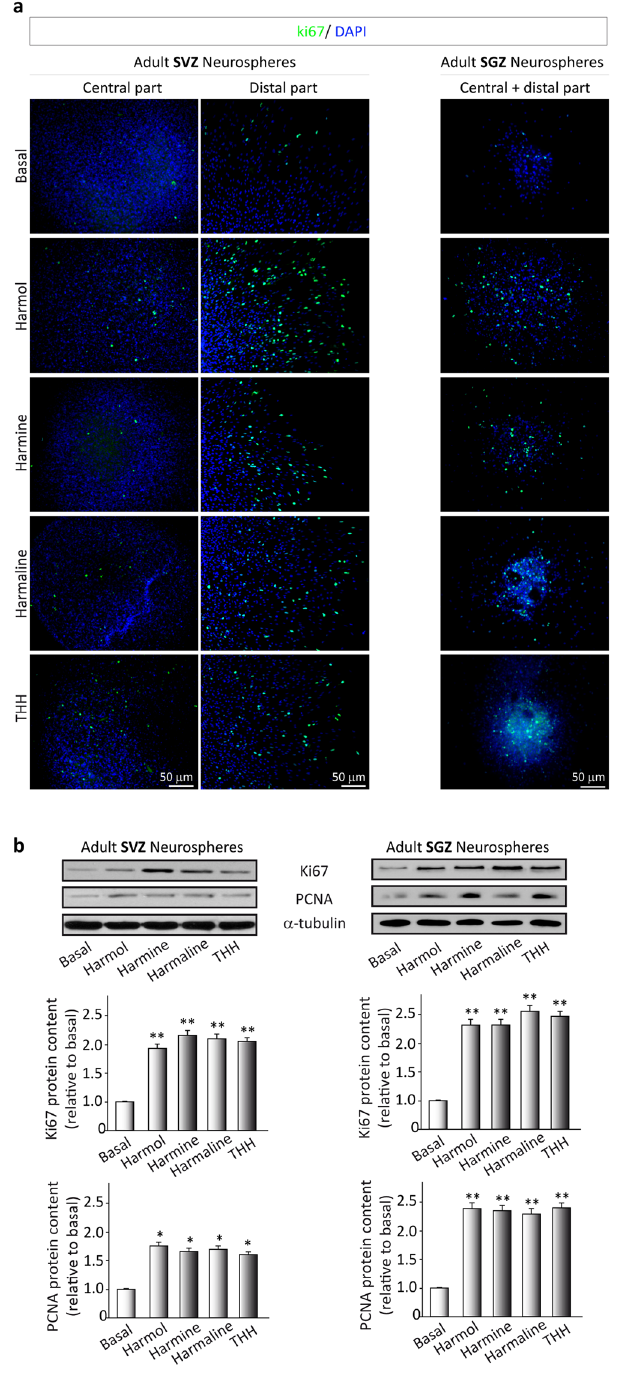
Figure 3. Effects of ayahuasca β -carboline alkaloids on adult neural stem cells proliferation. ( a ) Representative immunofluorescence images showing the expression of the cellular marker for proliferation ki67 (green) in neurospheres derived from the subventricular zone (SVZ) of the lateral ventricle and the subgranular zone (SGZ) of the hippocampus. SVZ-derived neurospheres are shown in two panels showing the central part of the sphere (left) and the distal migration site (right). Single images from SGZ-derived neurospheres show the whole neurosphere, including the central and distal areas. DAPI was used for nuclear staining. Scale bar = 50 μ m. ( b ) Representative Western blots of ki67 and the proliferating cell nuclear antigen (PCNA) levels in neurospheres treated for 7 days with each of the four alkaloids tested (1 µ M). Bar graphs show the results of the quantification analyses. Each bar indicates relative protein levels expressed as mean ± SD of the quantification of at least three independent experiments corresponding to four different cellular pools. The left side of the image shows results for the subventricular zone (SVZ) of the brain. The right side of the image shows results for he subgranular zone of the hippocampus (SGZ). * p ≤ 0.05; ** p ≤ 0.01 indicate significant results in the post-hoc pair-wise comparisons (Bonferroni) versus non-treated (basal)